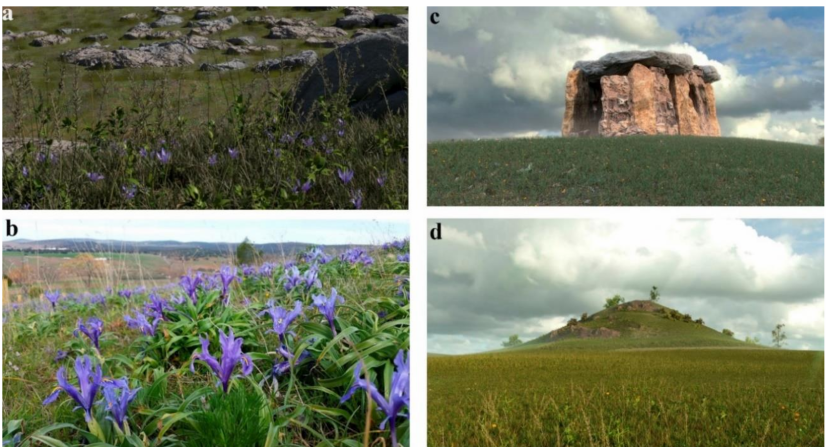
Figure 14. Area surrounding the CCB: ( a ) Juno planifolia shown in VR; ( b ) Juno planifolia in autumn-winter in the CCB; ( c ) megalithic monument (Figure 2a) shown in VR; ( d ) acropolis of the Roman city of Mellaria shown in VR. Images from Lithodomos VR for “Ager Mellariensis” / AEI FEDER HAR